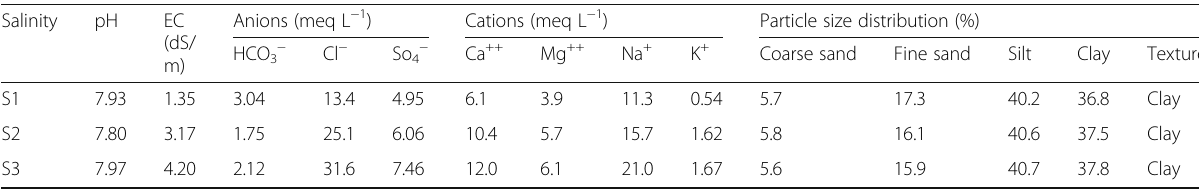
Table 1 Physical and chemical analyses of the experimental soil Salinity